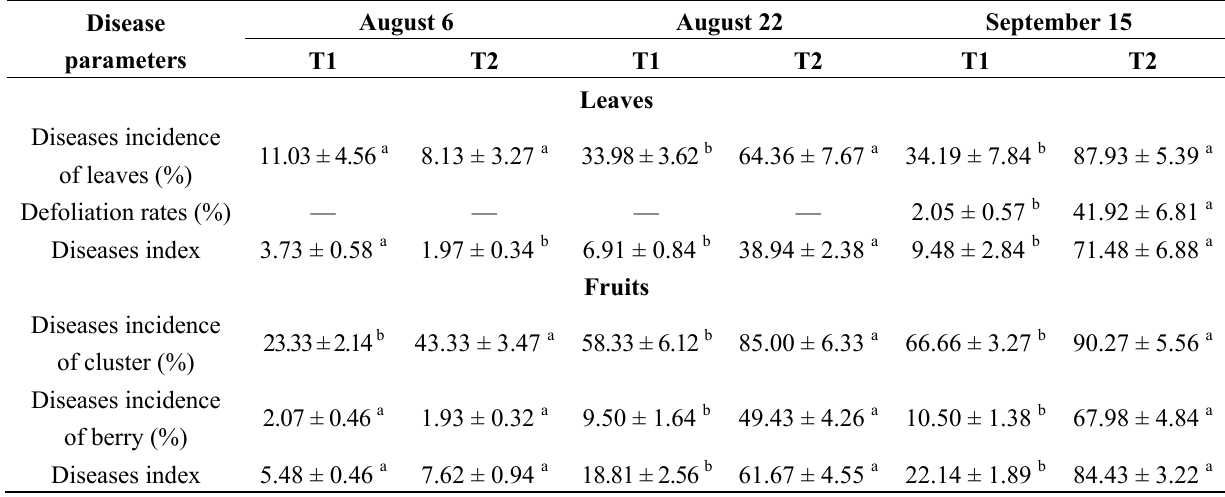
Table 1. Diseases of grape leaves and fruits under rain-shelter cultivation (T1) and open-field cultivation (T2) during ripening in the 2010 vintage.